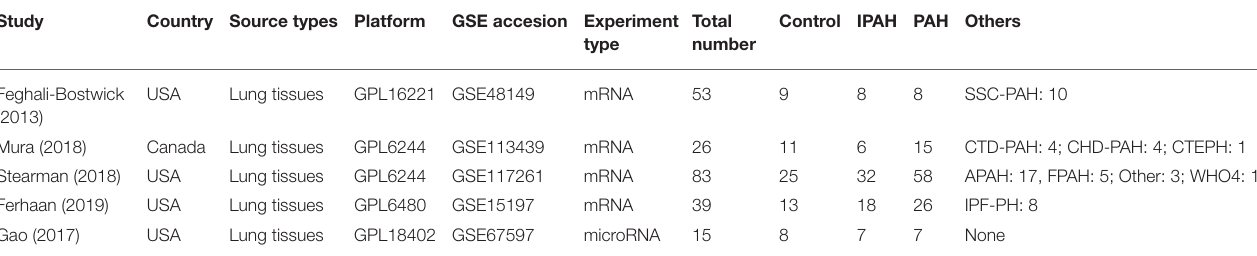
TABLE 1 | Summary of those five expression datasets involved in our study.